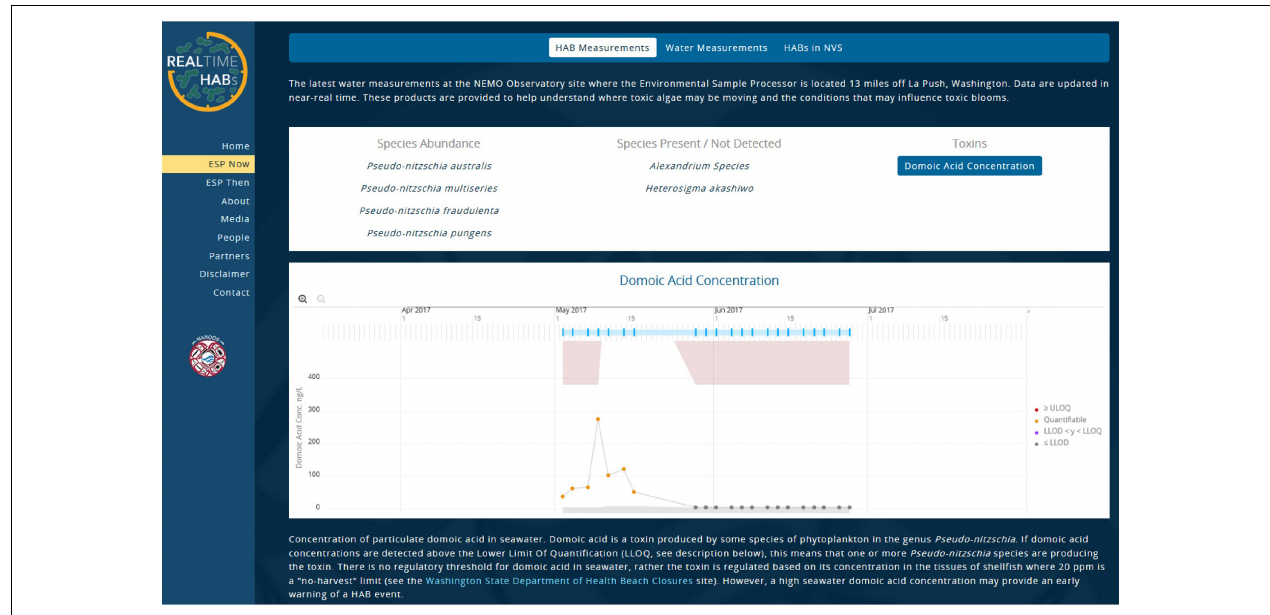
FIGURE 13 | Domoic Acid concentration from an ESP, deployed on a mooring near La Push, Washington. The ESP was deployed by University of Washington and NOAA Northwest Fisheries Science Center through US IOOS funding to NANOOS. Source: NANOOS (http://www.nanoos.org/products/habs/real-time/esp_now/hab_measurements.php).